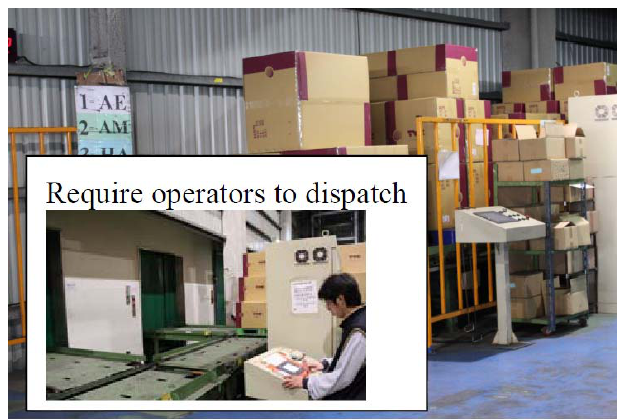
Figure 3. Pallets and goods on the conveyer. Operators are required to dispatch cargo into categories (as-is).